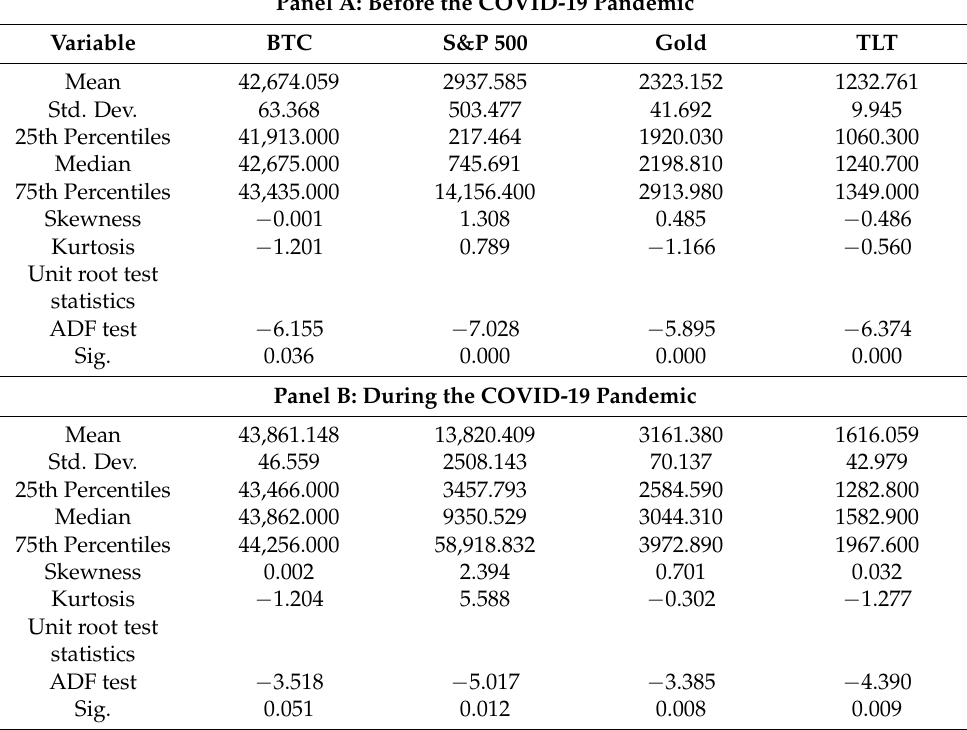
Table 1. Descriptive statistics. Panel A: Before the COVID-19